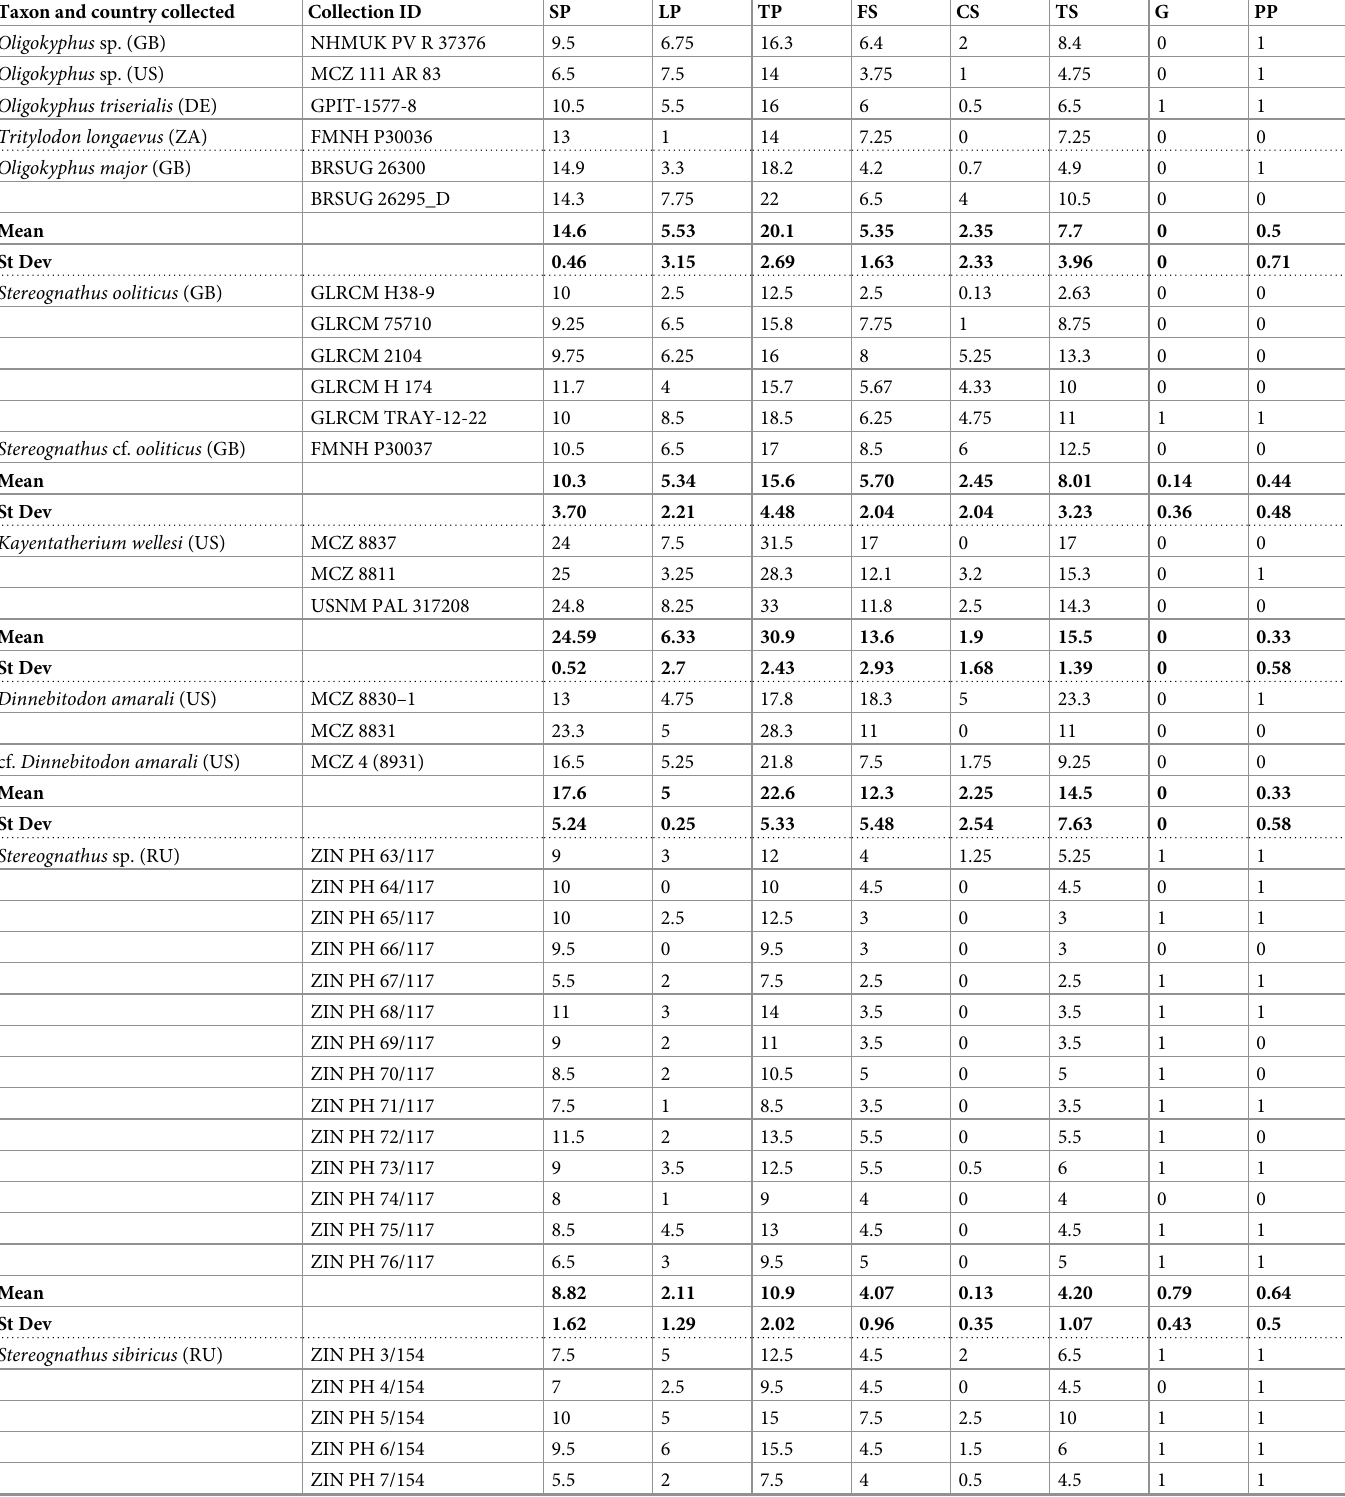
Table 2. Stereoscopic microwear parameters for all